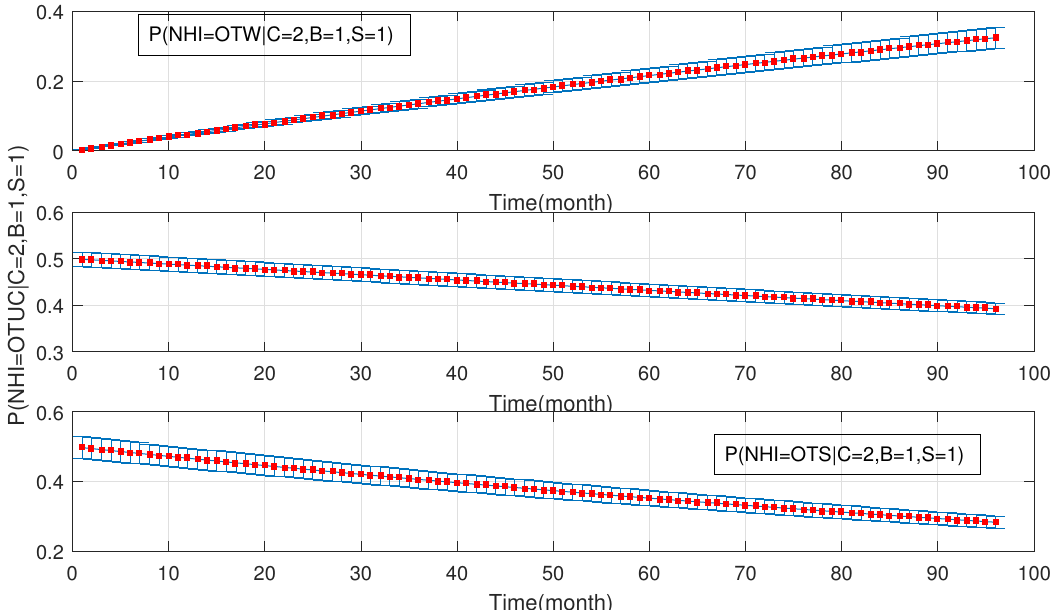
Figure 15. The probability of new herd incident (NHI) (officially TB free status withdrawn (OTW), officially TB free status unclassified (OTUC), officially TB free status suspended (OTS)) in high-risk areas of England where B: badgers density is > 3 setts/ ha; S: silage fed; and C: manure stored for less than six